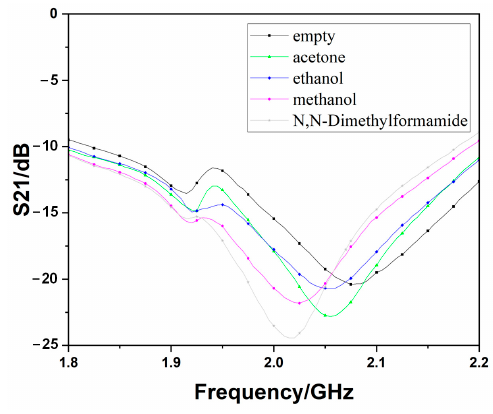
Figure 9. The measurement results of the basic device.